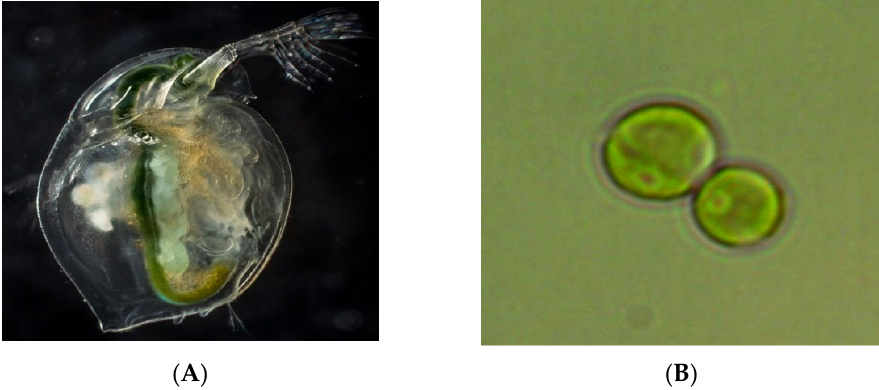
Figure 1. Test objects: ( A ) Daphnia magna Straus , ( B ) Chlorella vulgaris Beijer .